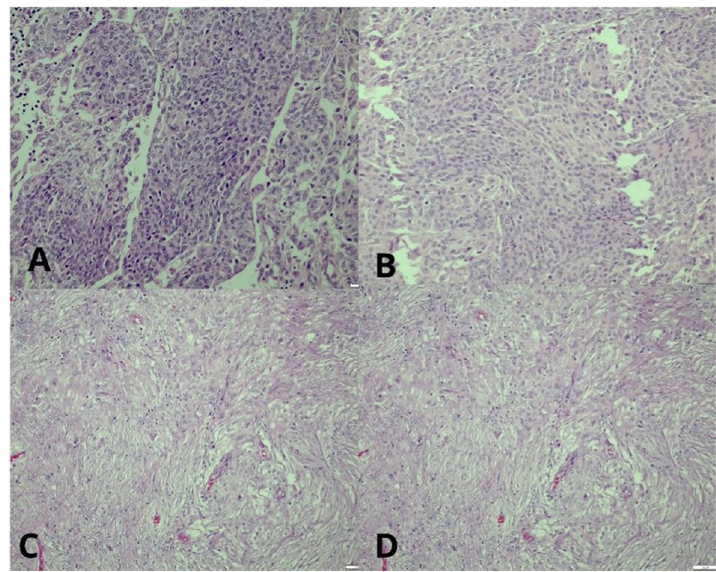
Fig. 3 Image showing the H&E-stained sections of the specimen. A , B Focal increased cellularity (20 cells arranged in fascicles, whorled in diffuse sheet (10